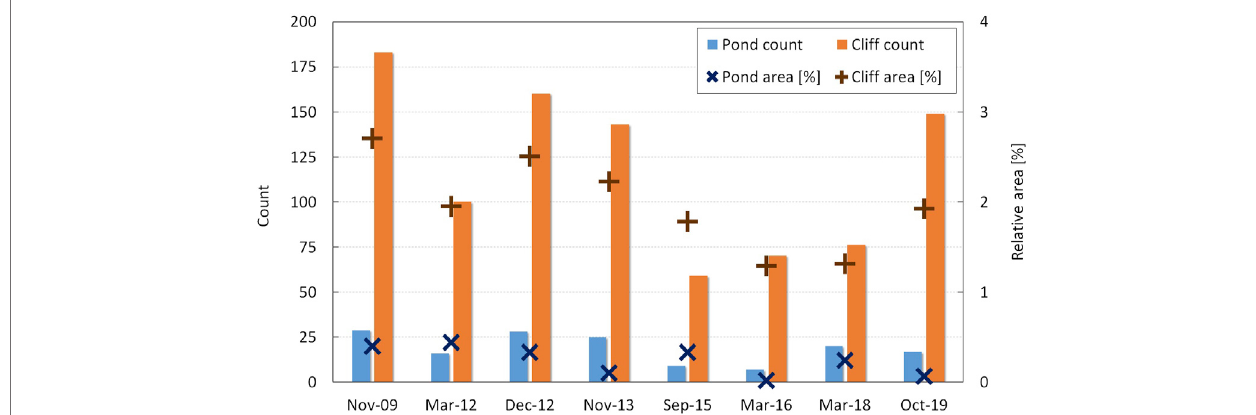
FIGURE 5 | Observed ponds and ice cliffs number and area.